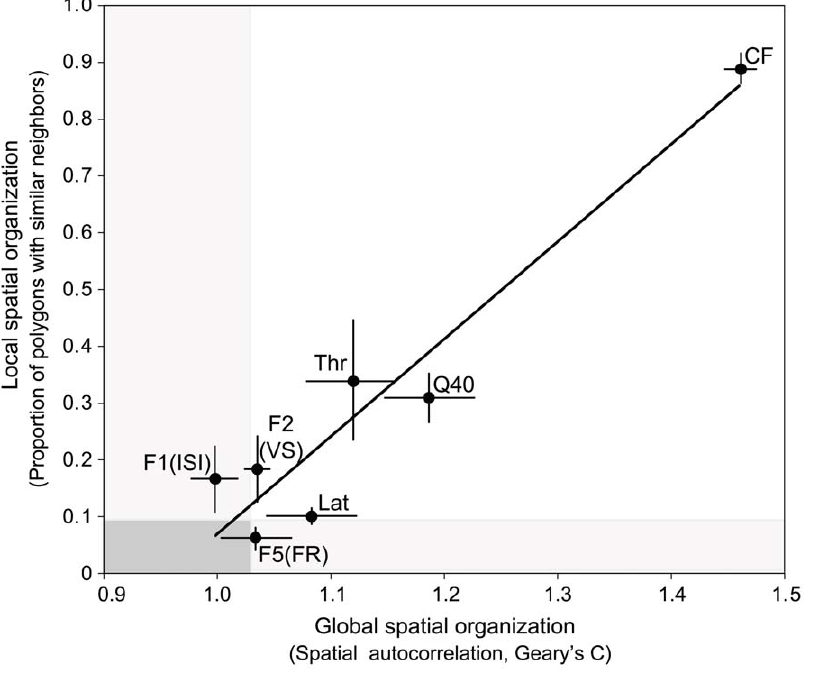
Figure 8. Local versus global spatial organization in AAF. A scatter plot of the mean proportion of polygons with high magnitude similarity to directly neighboring polygons (local spatial organization) versus a mean spatial autocorrelation measure (Geary’s C; global spatial organization) for all three hemispheres (see Table 2). Error bars indicate standard error of the mean. Light gray shading indicates statistically non-significant regions for either measure. Dark gray area corresponds to value range that is not statistically significant for either local or global measures. A linear regression line is shown ( r 2 =0.92, p , 0.001). CF=characteristic frequency; Q40=frequency tuning curve bandwidth (at 40 dB above threshold)/CF; Lat=minimum response latency at CF; F1(ISI)=strongest temporal factor comprising CV min, ISI info, and FR max; F2(VS)=second strongest temporal factor comprising VS max and VS info F5(FR)=third strongest temporal factor comprising FR info.